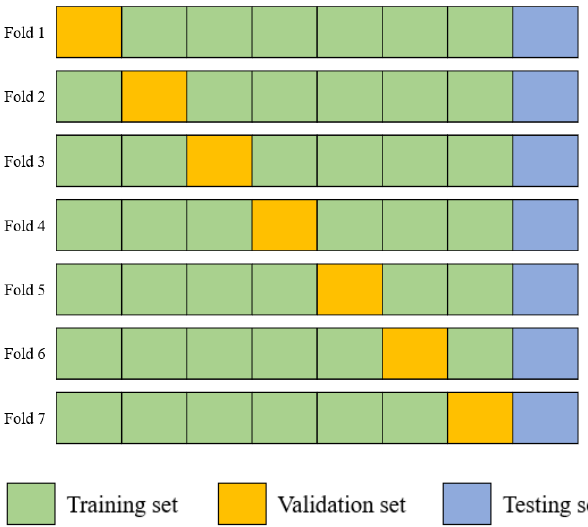
Figure 14. Illustration of the seven-fold cross validation method.